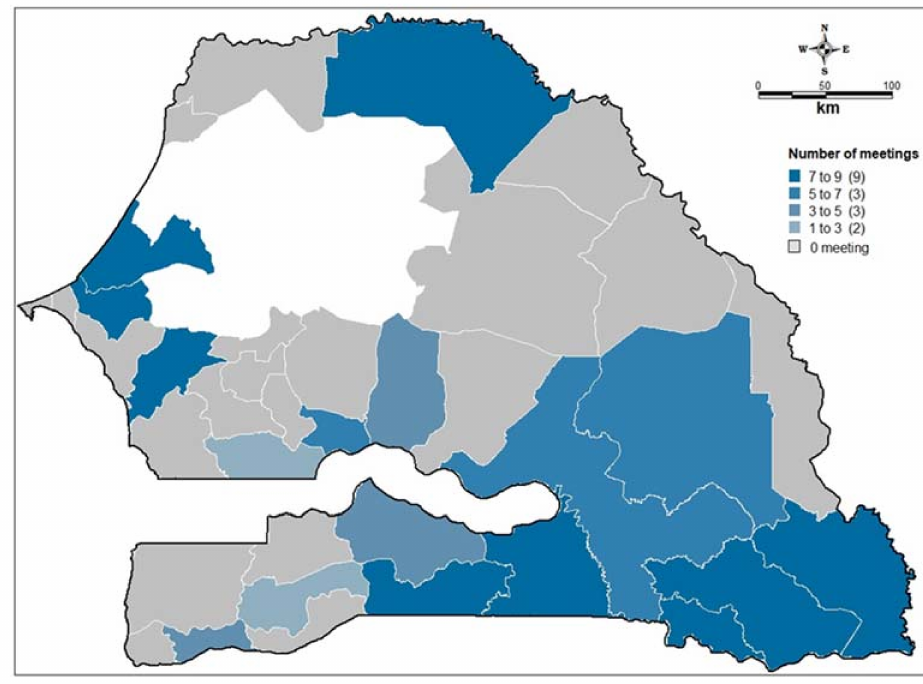
Figure 4. Functionality status of the MWGs (source: from